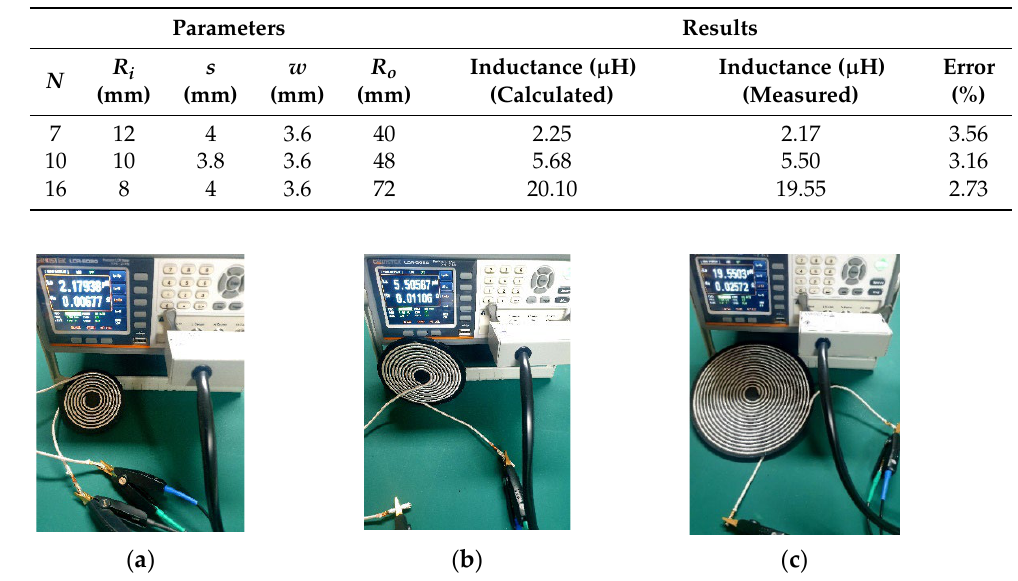
Figure 10. Measured inductances of the spiral coil with different sizes. ( a ) 7 turns. ( b ) 10 turns. ( c ) 16 turns.